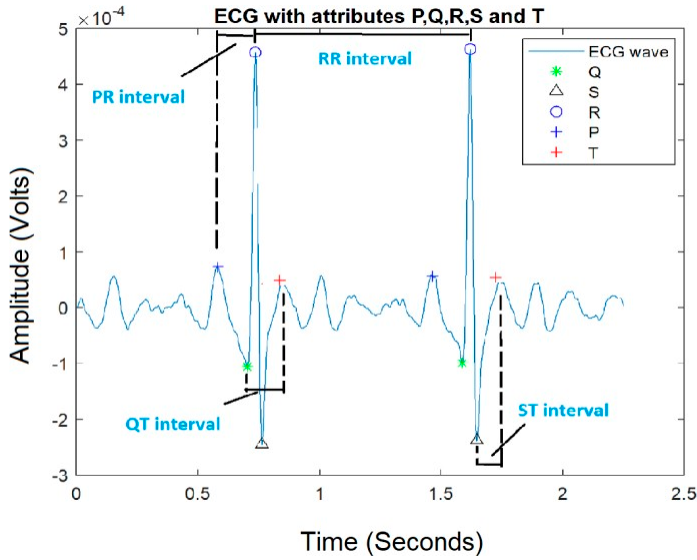
Figure 4. Components marked in the ECG wave show time intervals of various segments.